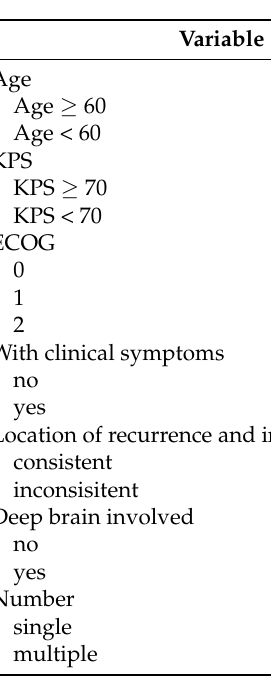
Table 1. Summary of clinical